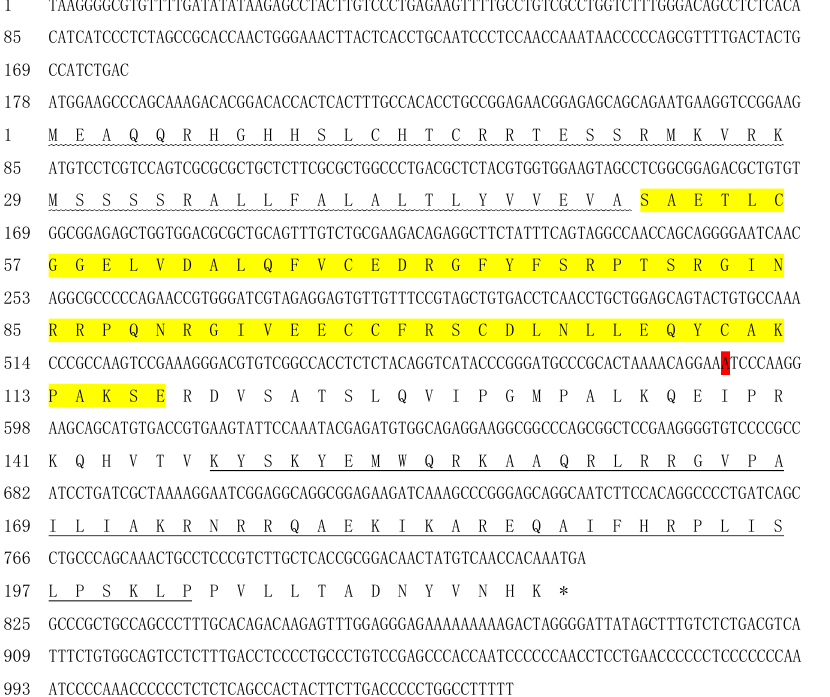
Figure 1. cDNA and deduced amino acid sequence of igf2 . The positions of the cDNA and deduced amino acid sequences are shown by numbers on the left. The signal peptide is presented as a wavy line. The IGF domain is in yellow. The IGF2_C domain is underlined. The SNP is in red.